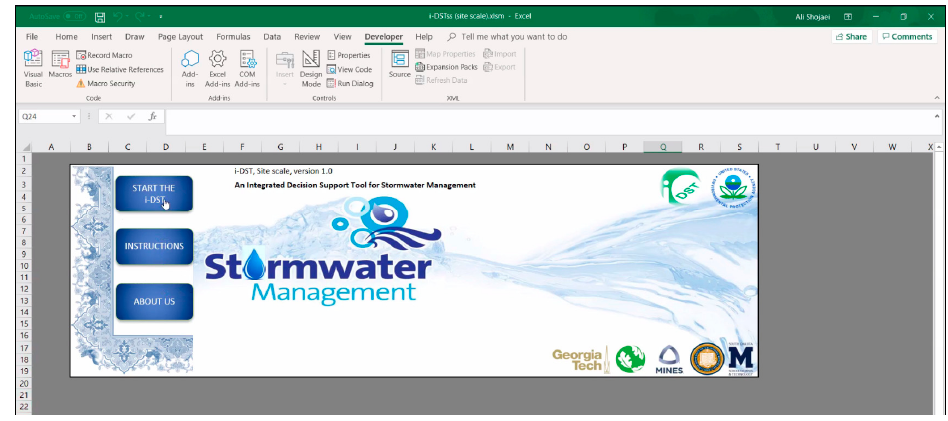
Figure A2. i-DSTss Introductory page.